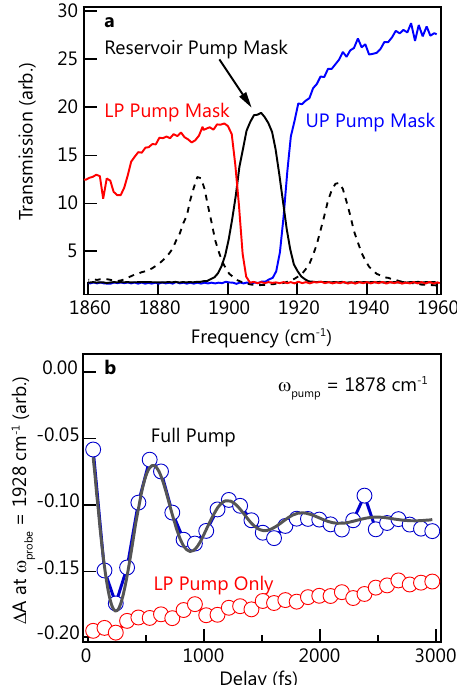
Fig. 3 Pump fi ltering masks and pump fi ltered transient spectra of cavity- coupled SNP. a Selective-pump masks used to selectively excite either the UP, LP, or reservoir. The blue trace is the spectrum of the pump pulse after fi ltering with the UP Pump mask; the red trace is the spectrum of the pump pulse after fi ltering with the LP Pump mask; the black trace is the spectrum of the pump pulse after fi ltering with a Reservoir-Pump mask. The black dashed line is the static transmission of the probe pulse through the 25 μ m Fabry – Pérot cavity. b Peak intensity decays of the 2D IR spectrum measured at ω probe = 1928 cm − 1 . The blue trace corresponds to a full spectrum pump (i.e., no fi ltering), the red trace is measured with the LP Pump, and the gray solid line is the damped sinosoidual fi t to the